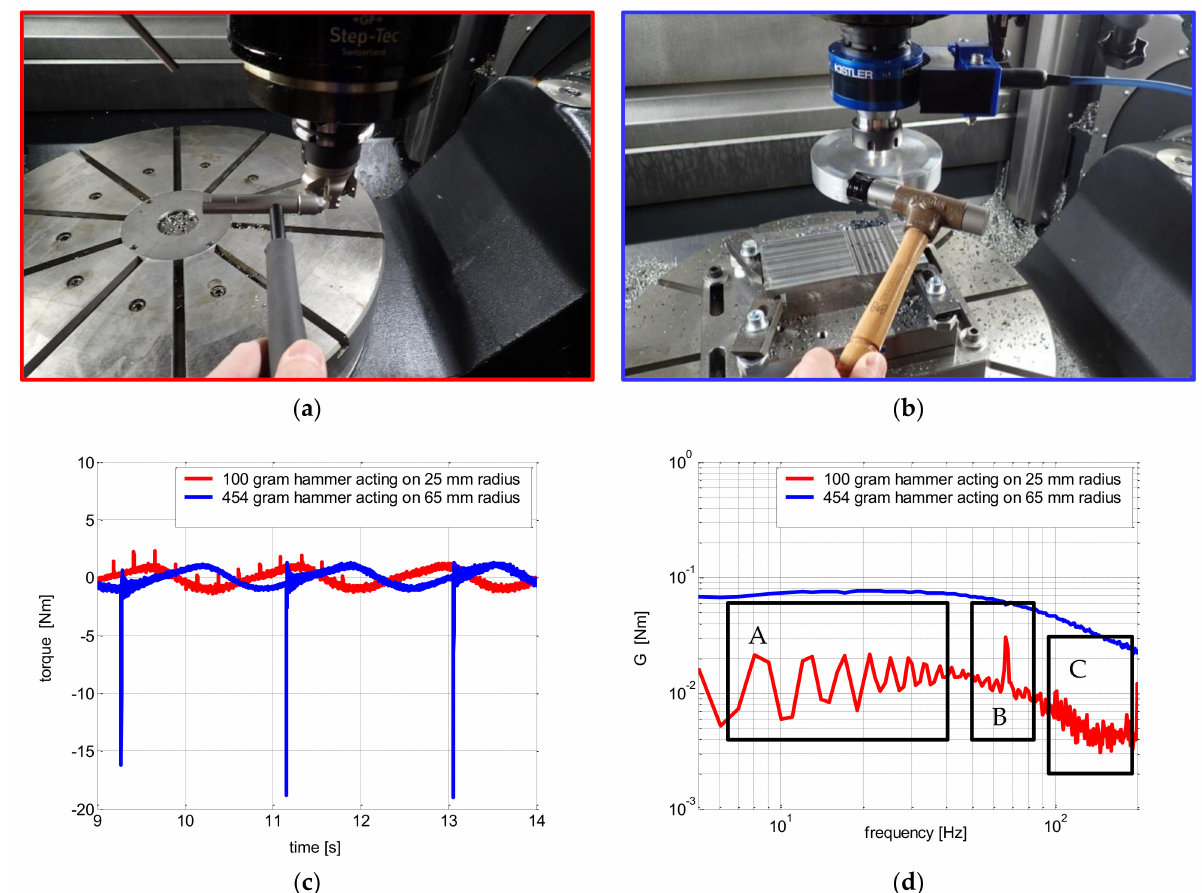
Figure 5. Calibration procedures for different hammer weights acting on different radii: ( a ) Case 1: 100 g hammer acting on 25 mm radius; ( b ) Case 2: 454 g hammer acting on 65 mm radius; ( c ) wave form of torque signals; ( d ) linear power spectra of torque